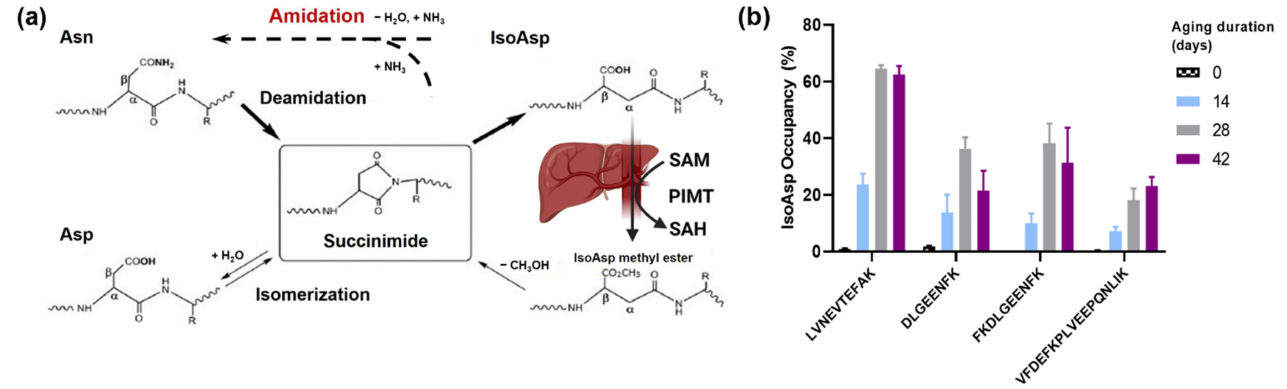
Figure 1. Proposed protein succinimide/isoaspartate ammonia (PSIAL) activity. ( a ) The mecha- nism of isoAsp formation and repair by PMIT and the proposed amidation via enzymes with PSIAL activity. ( b ) The deamidation degree of asparaginyl peptides in HSA after artificial deamidation for 42